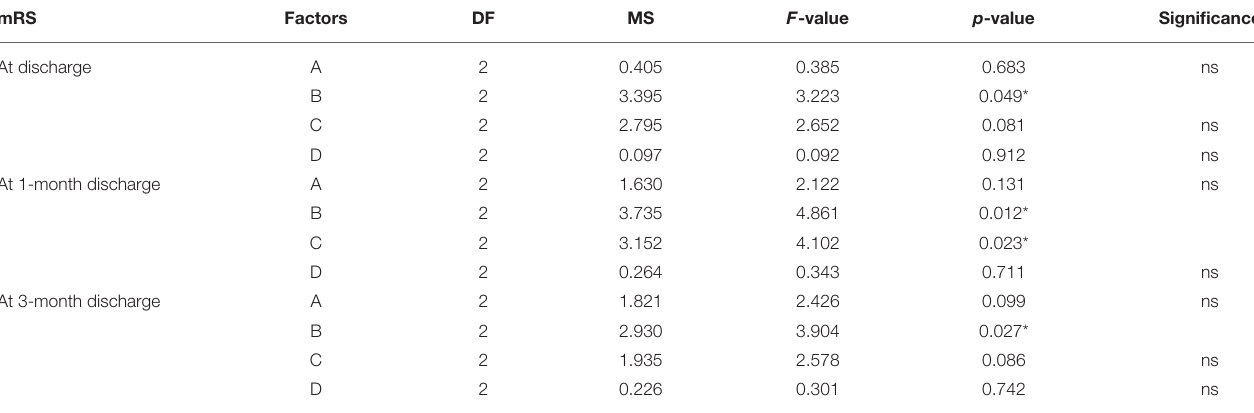
TABLE 12 | ANOVA of the factors affecting the degree of disability. mRS Factors DF MS F -value p -value Significance At